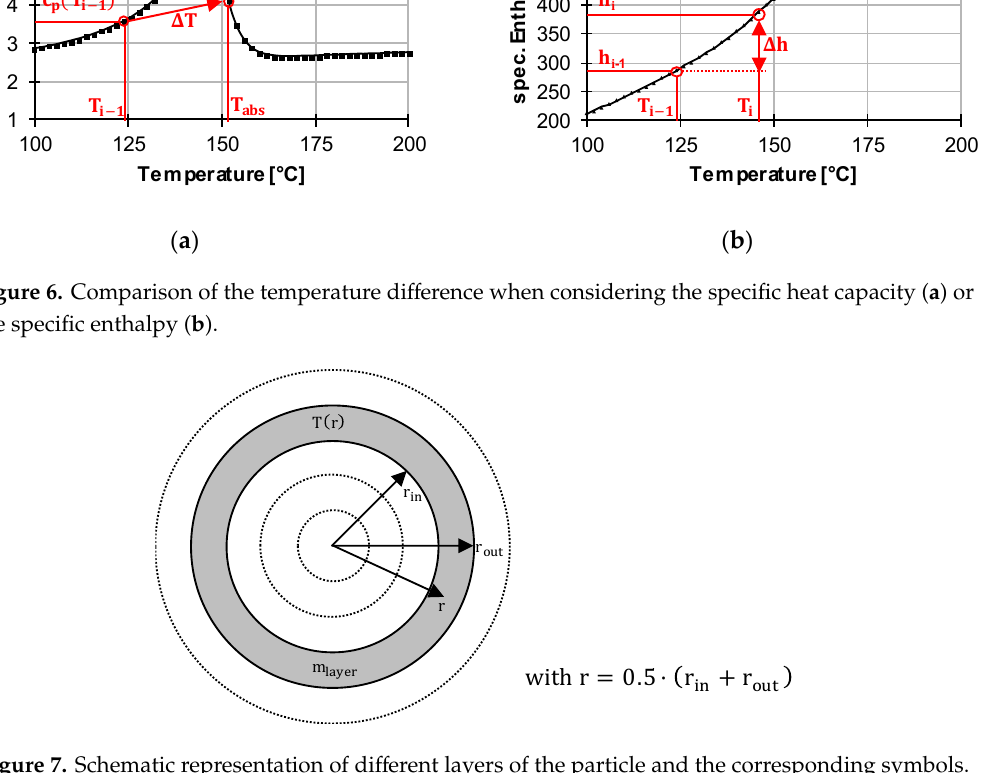
Figure 7. Schematic representation of different layers of the particle and the corresponding symbols. For each layer, the respective temperature T i (r) is taken into account. The introduced energy can be calculated with the following equation by converting Equation (36) to E input .